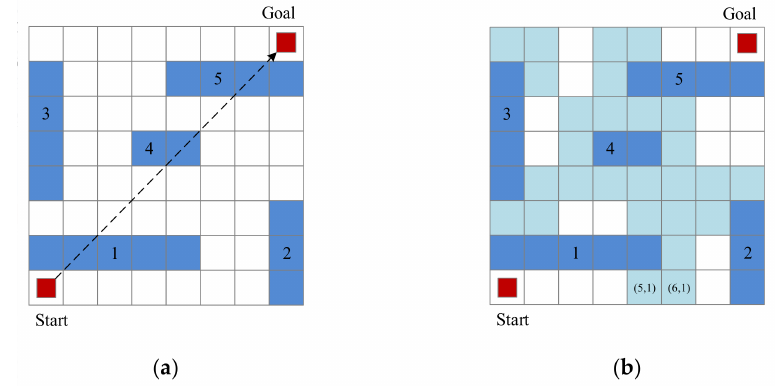
Figure 10. Selecting an effective free cell. ( a ) Direct path from the start to the goal; ( b ) effective free cells.